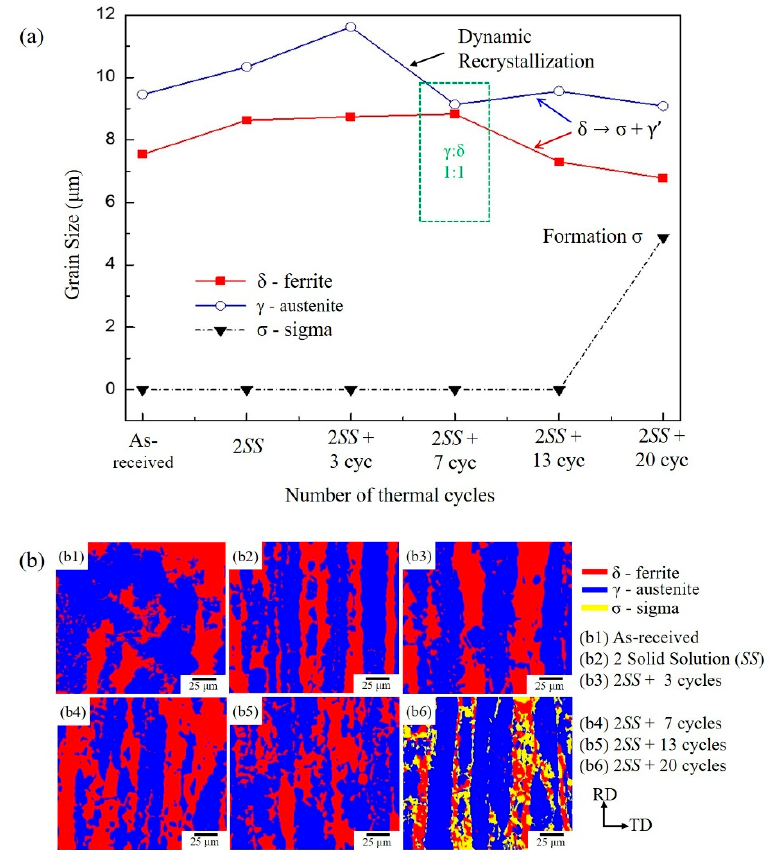
Figure 5. ( a ) Grain size variation of various phases versus the number of thermal cycles; ( b ) electron backscatter diffraction (EBSD) images for phase identification.